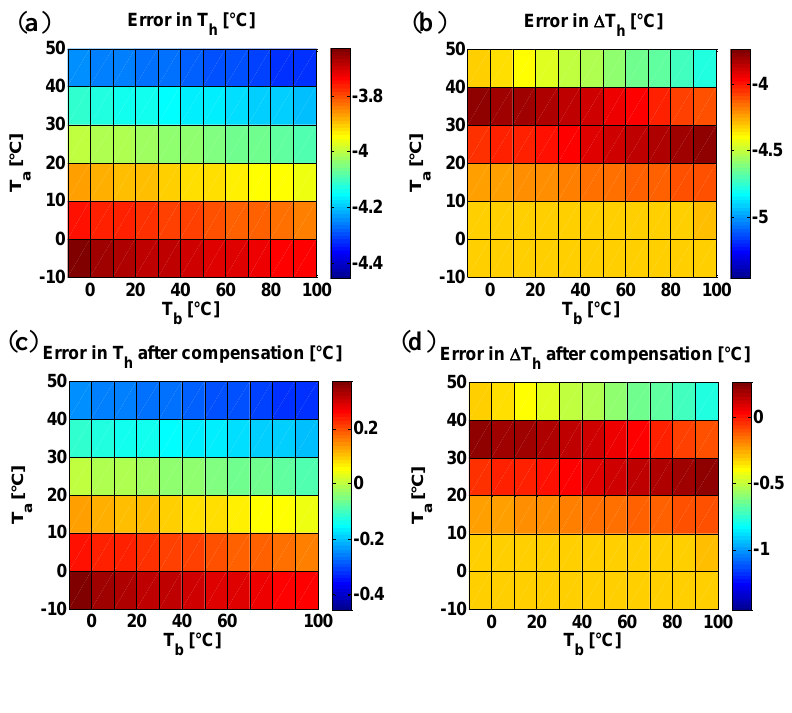
( a, c ) and h ( b, d h